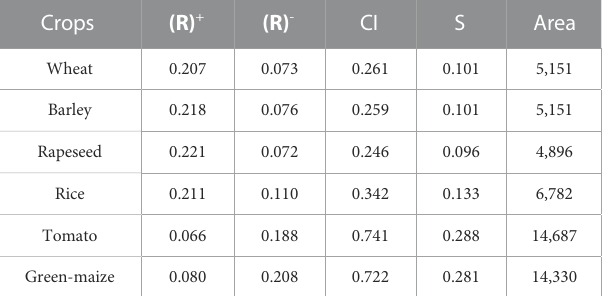
TABLE 5 The closeness index of crops, share and amount of cultivated area of crops based on WEFN. Crops